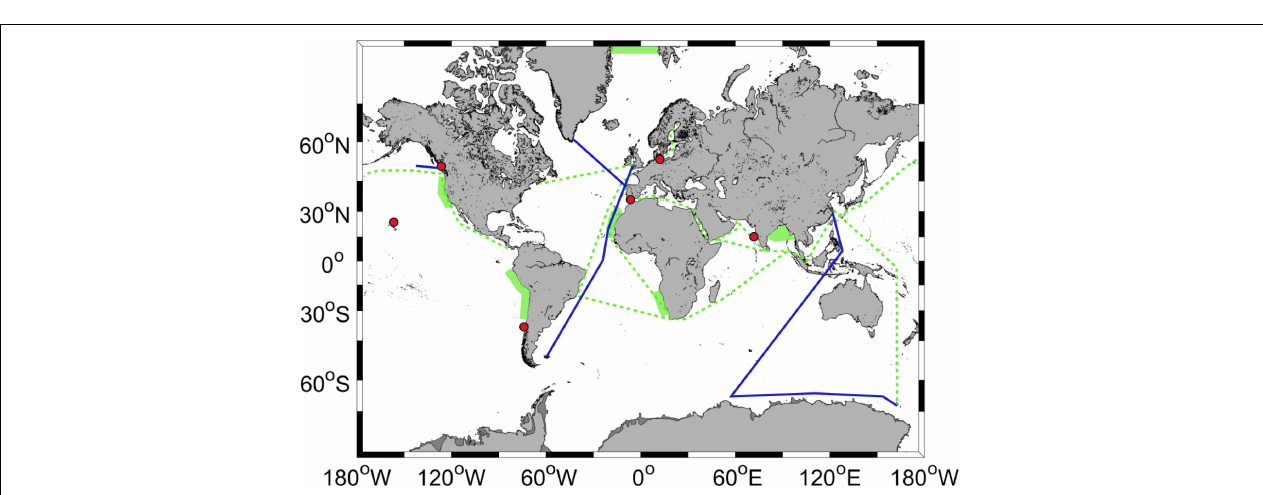
FIGURE 1 | Maps of the distribution of N 2 O measurements in (A) December, January, February; (B) March, April, May; (C) June, July, August and (D) September, October, November. Red lines indicate continuous surface measurements. Blue dots indicate locations of N 2 O depth profiles. Data are from MEMENTO as of October 04, 2018 (https://memento.geomar.de/de).